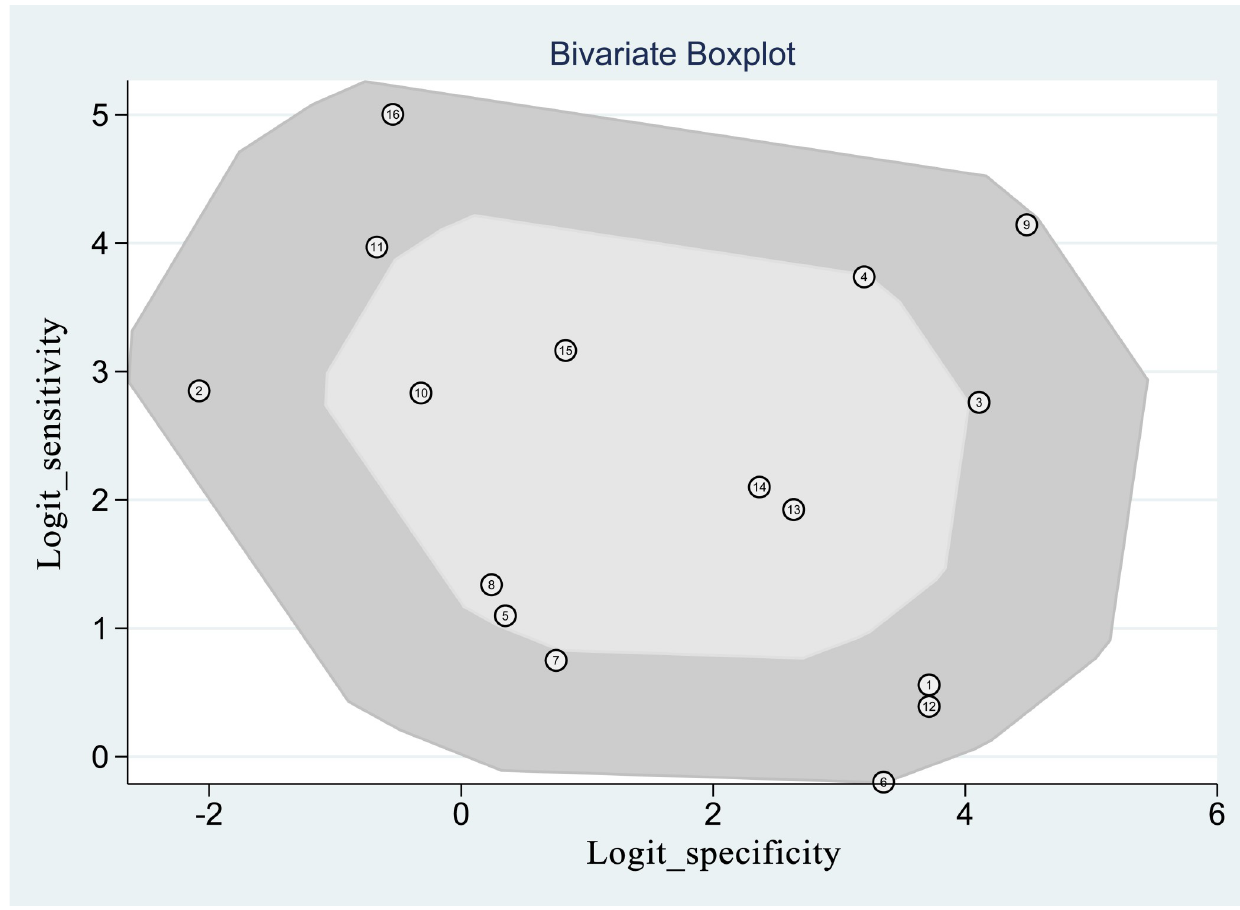
Fig 3. Bivariate boxplots of all included